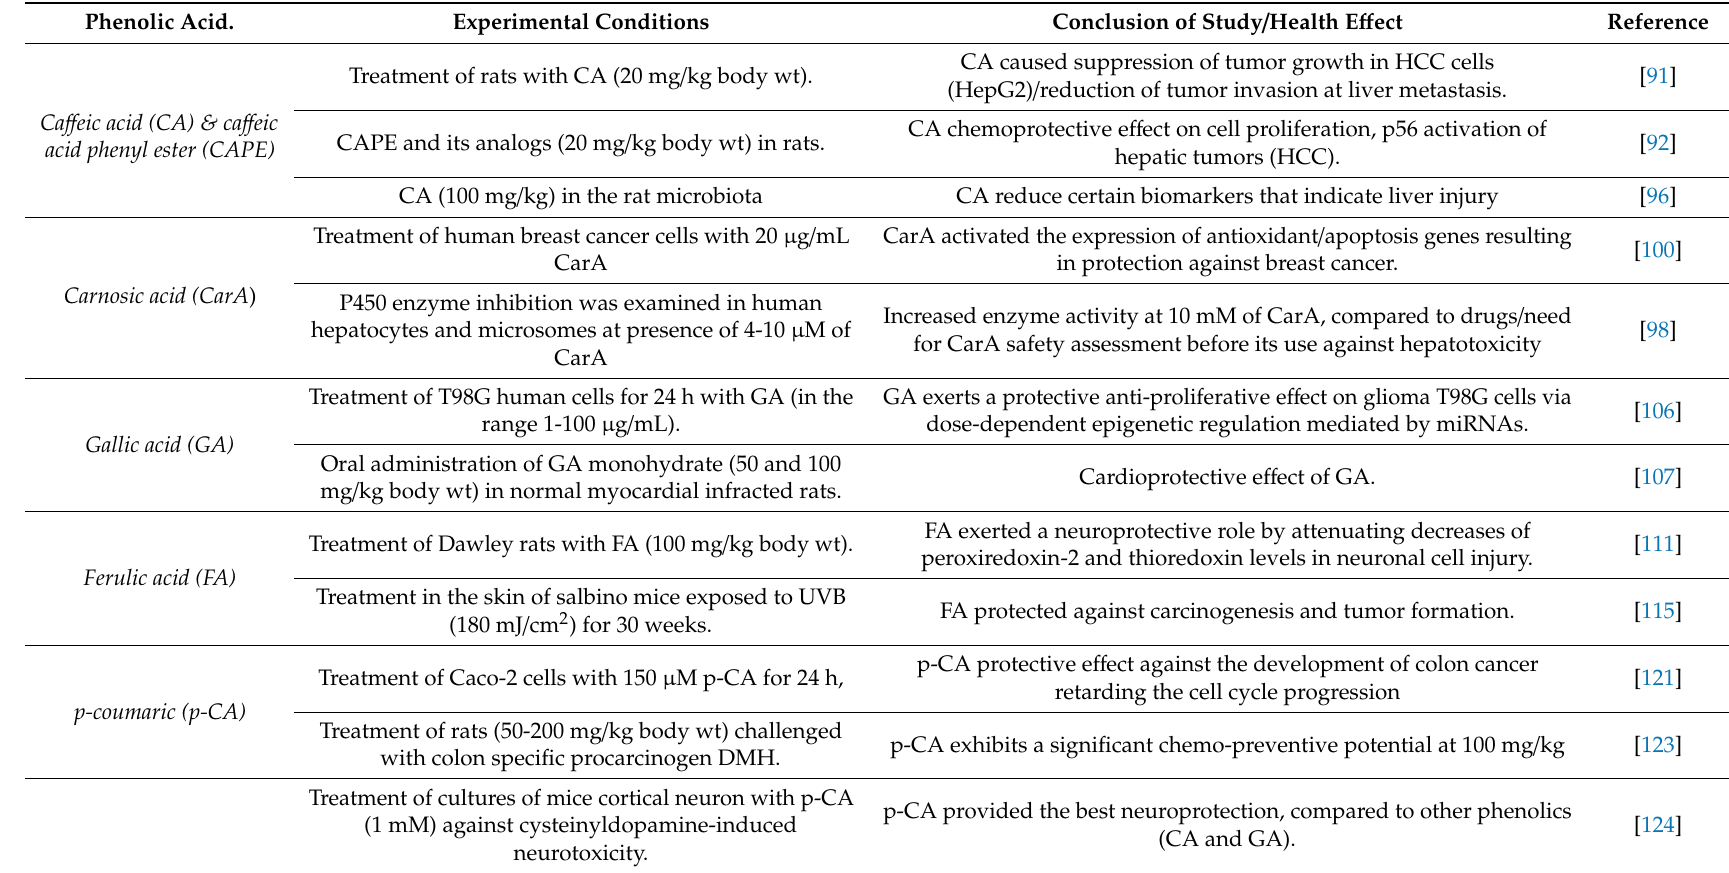
Table 2. Overview of recent in vitro and in vivo clinical studies on the beautiful health / biochemical properties of the examined phenolic acids. Phenolic